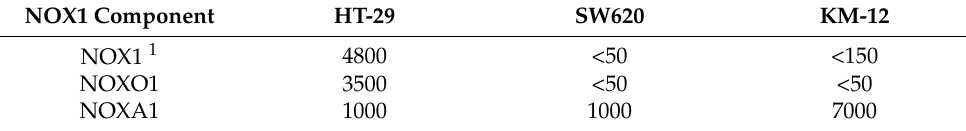
Table 1. Expression of the components of the NOX1 complex in human colon cancer cells.